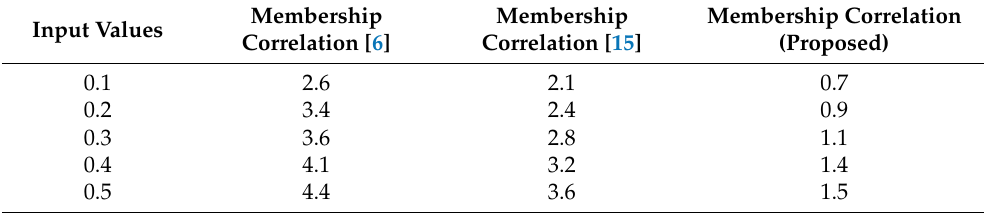
Table 5. Relationship of correlation: A